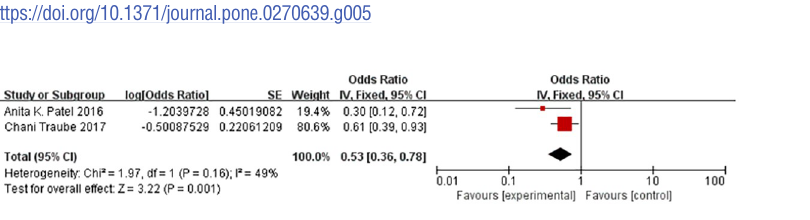
Fig 6. Forest plot for ages between 0 to 2 and 2 to 5. We conducted meta-analysis for 2 studies using a random effects model. We used ORs and 95% CIs to represent the results.